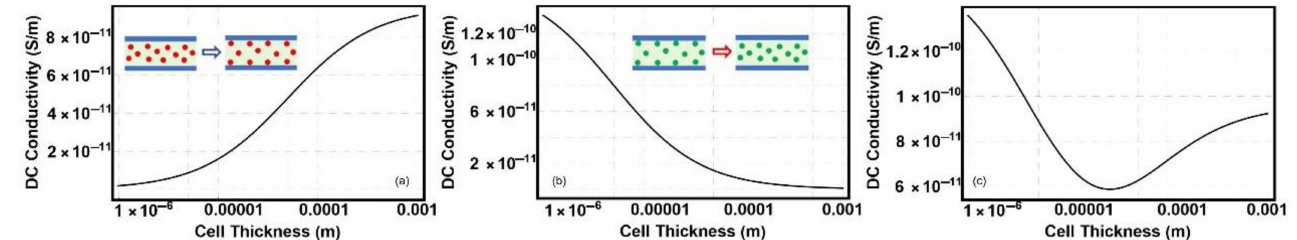
Figure 1. DC conductivity (steady-state) of liquid crystals as a function of the cell thickness. ( a ) DC conductivity caused by ions already present in liquid crystals. The values of the parameters used in the simulations are listed in Table 1 ( n 01 , ν S 1 , µ 1 , σ S 1 , K 1 ). ( b ) DC conductivity (steady-state) due to ions originating from contaminated substrates of the liquid crystal cell. The values of the parameters used in the simulations are listed in Table 1 ( n 02 , ν S 2 , µ 2 , σ S 2 , K 2 ). ( c ) DC conductivity (steady-state) caused by the combination of ion-capturing and ion-releasing processes shown in Figure 1a,b. The values of the parameters used in the simulations are listed in Table 1 ( n 01 , n 02 , ν S 1 , ν S 2 , µ 1 = µ 2 , σ S 1 = σ S 2 , K 1 , K 2 ). Reproduced from [33] under the Creative Commons Attribution License.